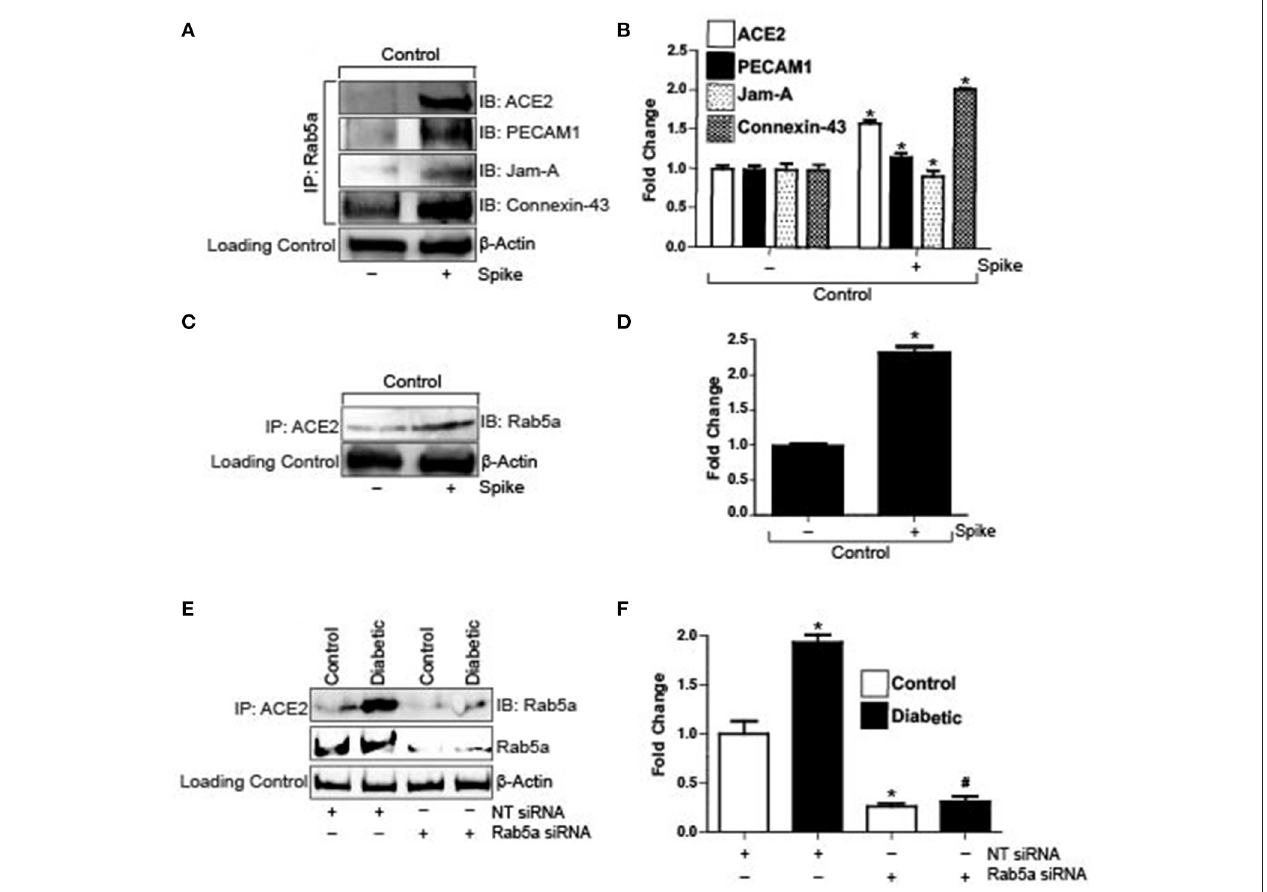
FIGURE 2 | Spike increases Rab5a association with ACE2 and junctional proteins. (A) Representative Western blot of coimmunoprecipitation experiments done using Rab5a antibody and probed for different proteins. (B) Mean data indicating fold change in Rab5a association with junctional proteins and ACE2 after S1RBD treatment. n = 6 for each, * P < 0.05 vs. untreated control. (C) Representative Western blot of coimmunoprecipitation experiments done using ACE2 antibody and probed for Rab5a. (D) Mean data indicating fold change in ACE2 association with Rab5a after Spike treatment. n = 6 for each, * P < 0.05 vs. untreated control. (E) Representative Western blot of coimmunoprecipitation experiments in control and diabetic cells after Rab5a knockdown with siRNA. (F) Mean data indicating fold change in ACE2 association with Rab5a after Rab5a siRNA. n = 6 for each, * P < 0.05 vs. control, # P < 0.05 vs. NT siRNA